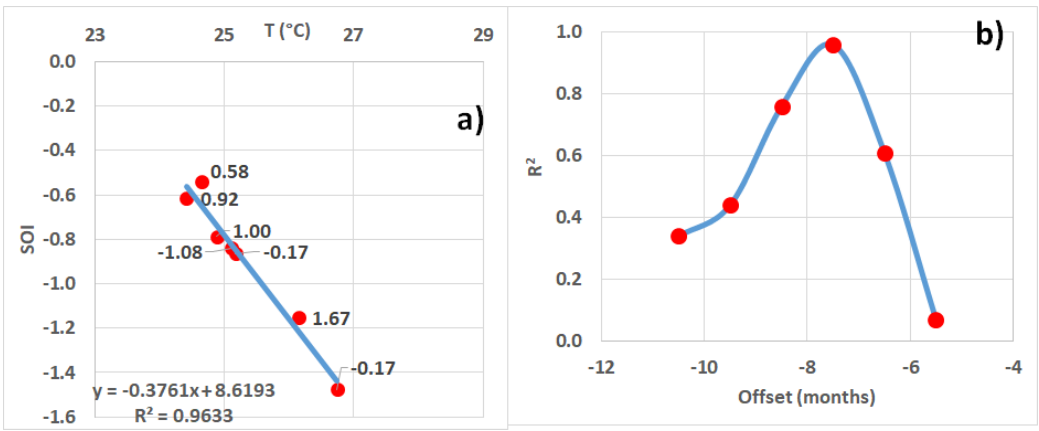
Figure 5. ( a ) For every ENSO event inventoried in Table 1, the correlation between the minimum SOI filtered within the band of 1.5/15 years, and the monthly subsurface water temperature T at 2° S 180° W averaged over 125 to 175 m in depth, 7–8 months prior to the minimum SOI, is represented. The labels display the lag of the events (in years). ( b ) The coefficient of determination R 2 versus the offset (the mean time elapsed prior to the minimum SOI). Table 1. The lag (in years) and the sea temperature at 2° S 180° W averaged over 125 to 175 m in depth, 7–8 months prior to the minimum SOI of the ENSO events occurring between late 1992 and 2017. The lag is deduced from the date of appearance compared to the central value of 4 ‐ year intervals of January 1992 to January 1996, January 1996 to January 2000, etc.